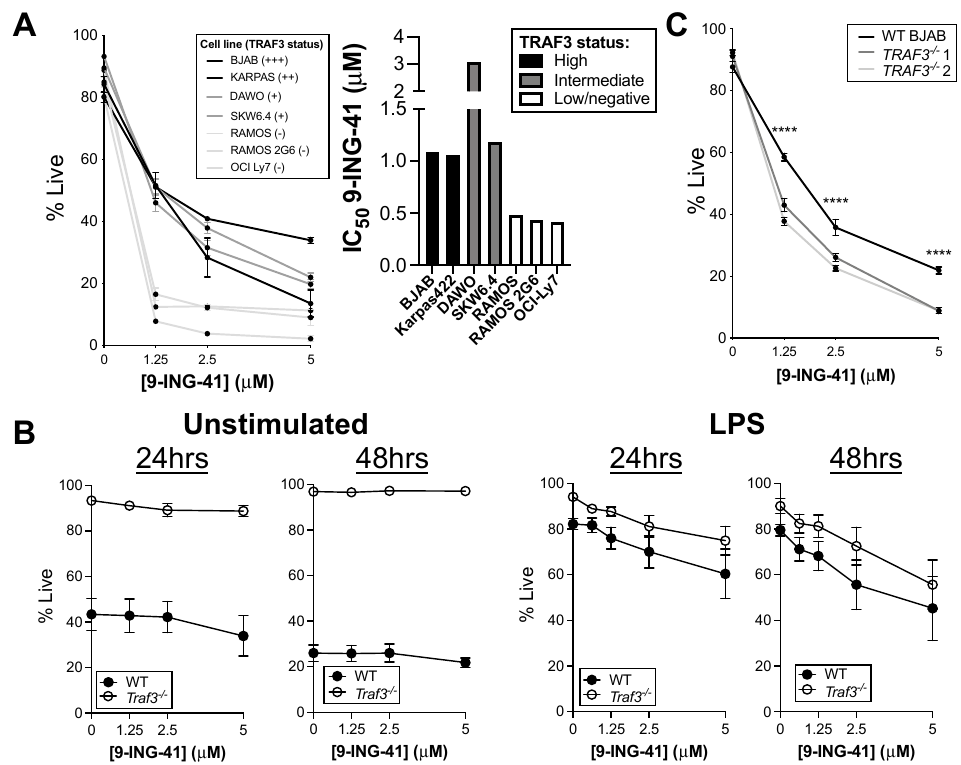
Figure 2. TRAF3 status of BCL cell lines affects susceptibility to GSK3 inhibition. ( A ) Survival of BCL cell lines after 48 h incubation with indicated concentrations of 9-ING-41 (left) and IC 50 calculated from survival data (right). ( B ) Survival of WT or Traf3 − / − primary mouse B cells after 24 or 48 h incubation with indicated concentrations of 9-ING-41. In right two graphs, cells were activated with LPS 2 h prior to initiation of 9-ING-41 treatment. ( C ) Survival of BCL cell line BJAB and two clones of TRAF3-deficient BJAB after 48 h incubation with indicated concentrations of 9-ING-41. Graphed are mean ± SEM for at least three independent replicates. **** p < 0.0001 by repeated measures ANOVA with Sidak’s multiple comparisons